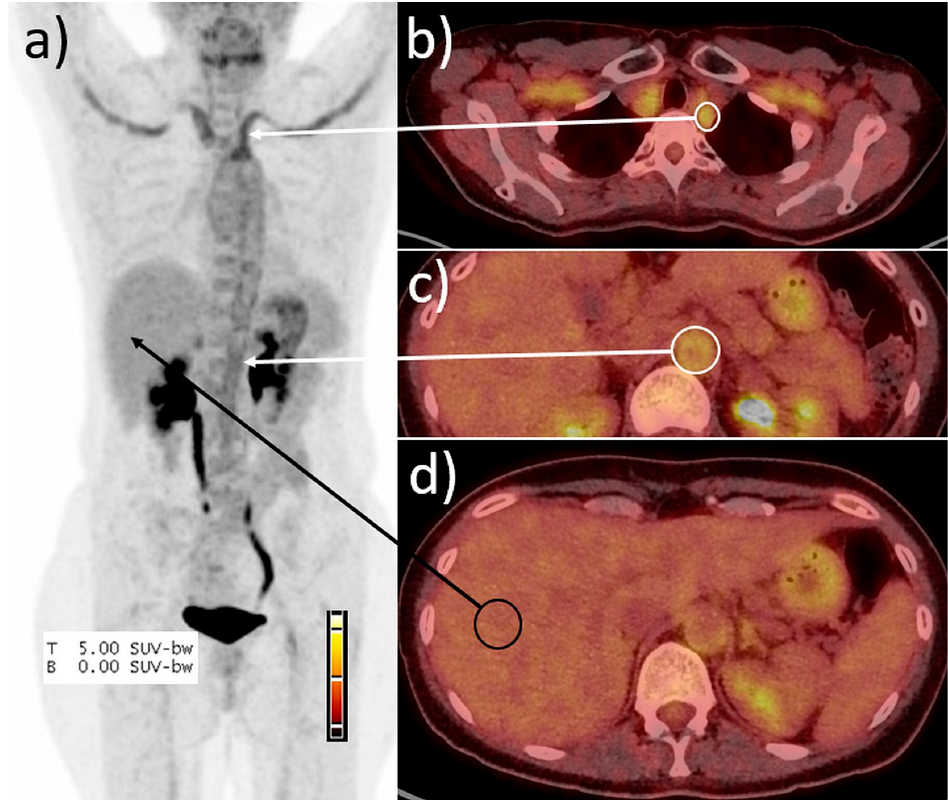
Figure 1. Example of the peak SUV ratio determination. ( a ): Maximum intensity projection, ( b – d ): fused PET/CT images. Calculation of the SUV ratio exemplified in patient #15. SUV max in the left subclavian artery (white circle, ( b ) was 3.7, in the abdominal aorta ( c ) 2.1, and in the right liver lobe (black circle) SUV mean was 1.6, resulting in a SUV ratio of 2.2 in maximum. In consequence, the scan was scored positive for vasculitis.